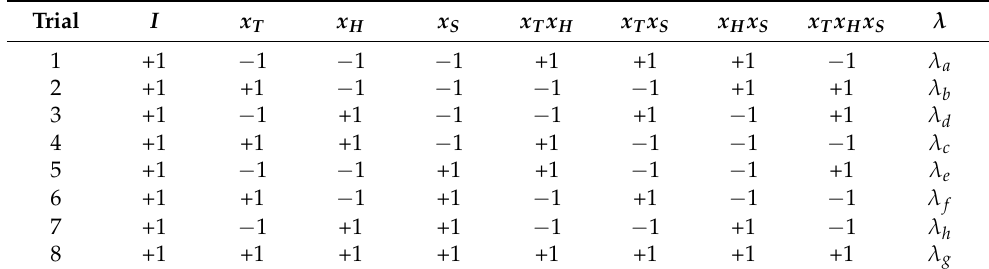
Table 2. Experimental matrix for a 2 3 factorial design of FBG response to temperature, humidity, and strain in CYTOP